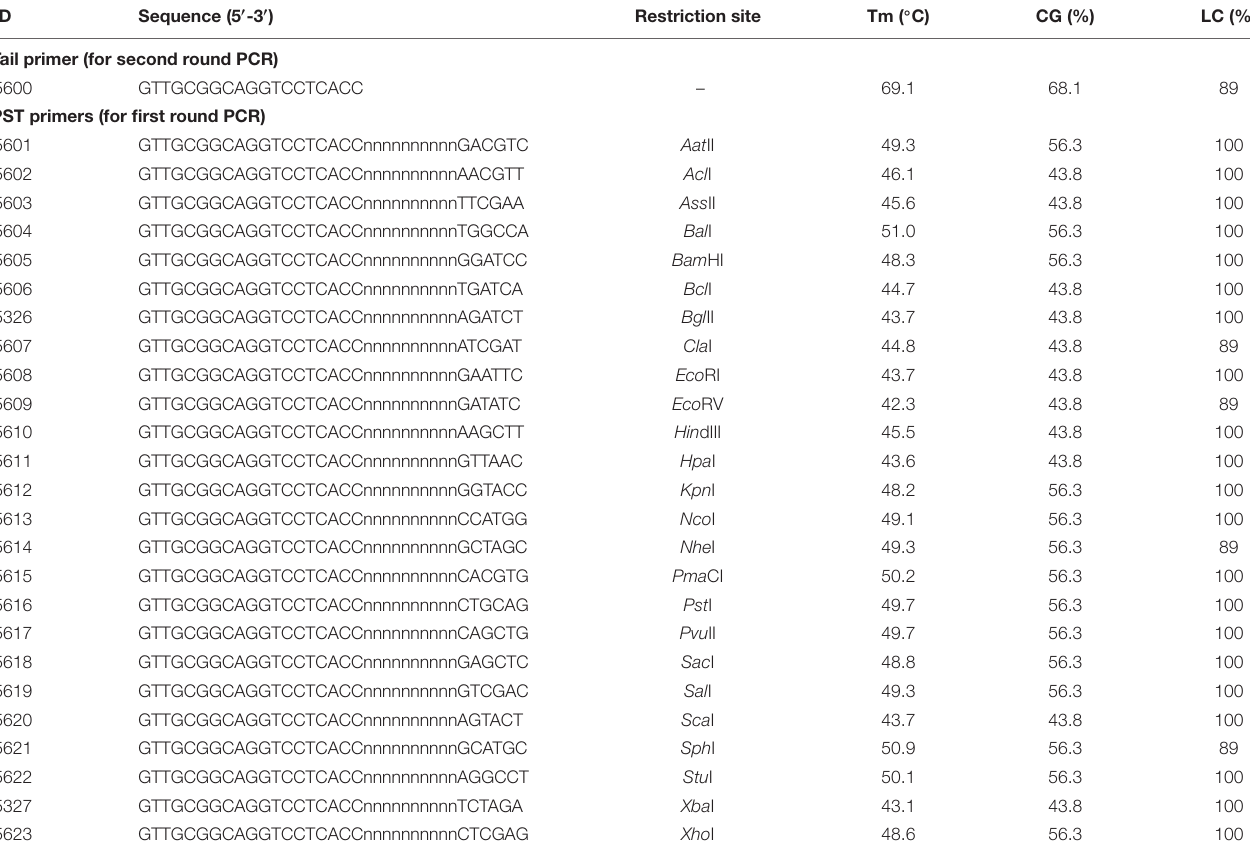
TABLE 2 | Primers for